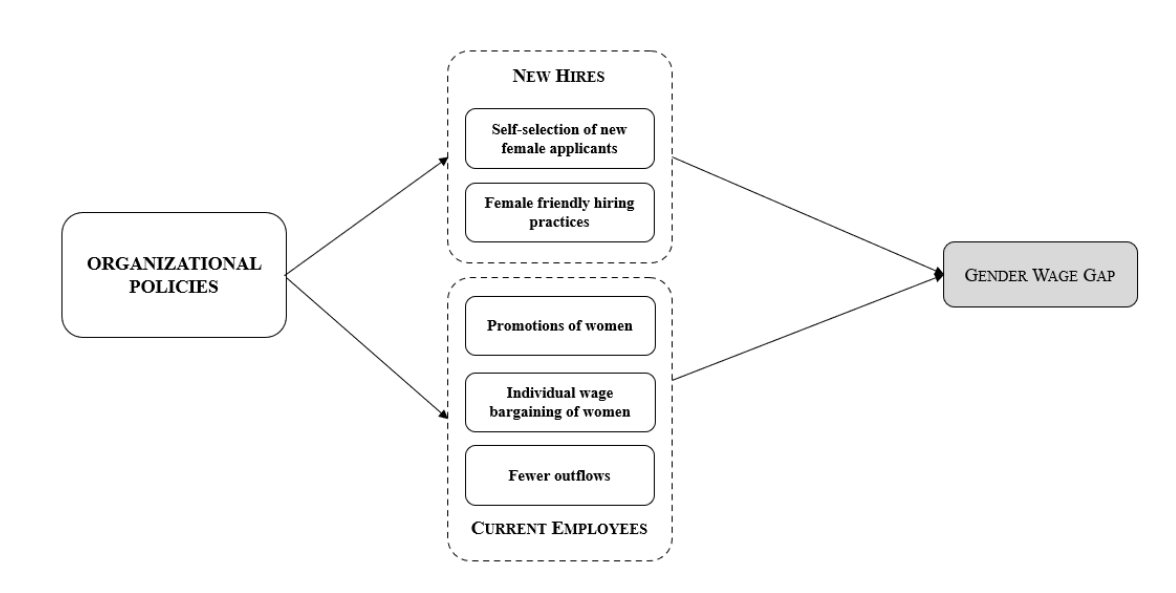
Figure 1: Channels through which organizational policies can affect gender wage gaps in